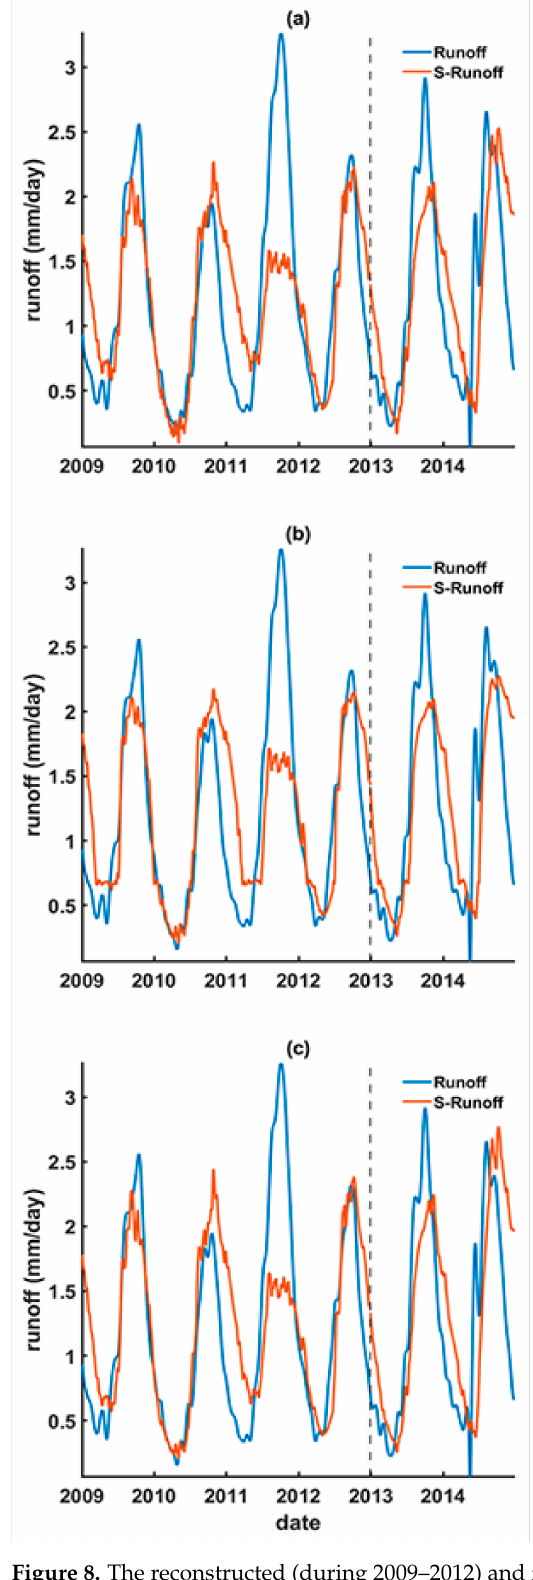
Figure 8. The reconstructed (during 2009–2012) and forecasted (during 2013–2014) runoff using the upstream GRACE land water storage (i.e., S-runoff) based on ( a ) linear regression, ( b ) ANN, and ( c ) LSTM